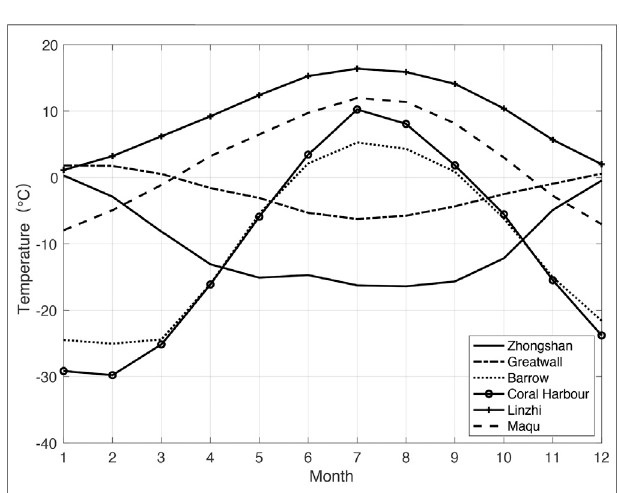
FIGURE 3 | Monthly variations in the surface air temperature at the Zhongshan, Greatwall, Barrow, Coral Harbour, Linzhi and Maqu stations.